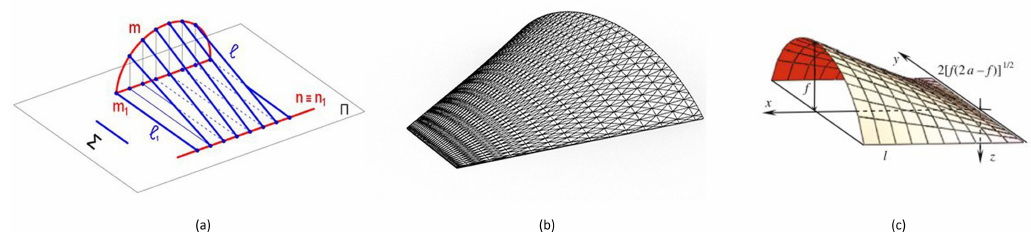
Figure 4: The conoid shell